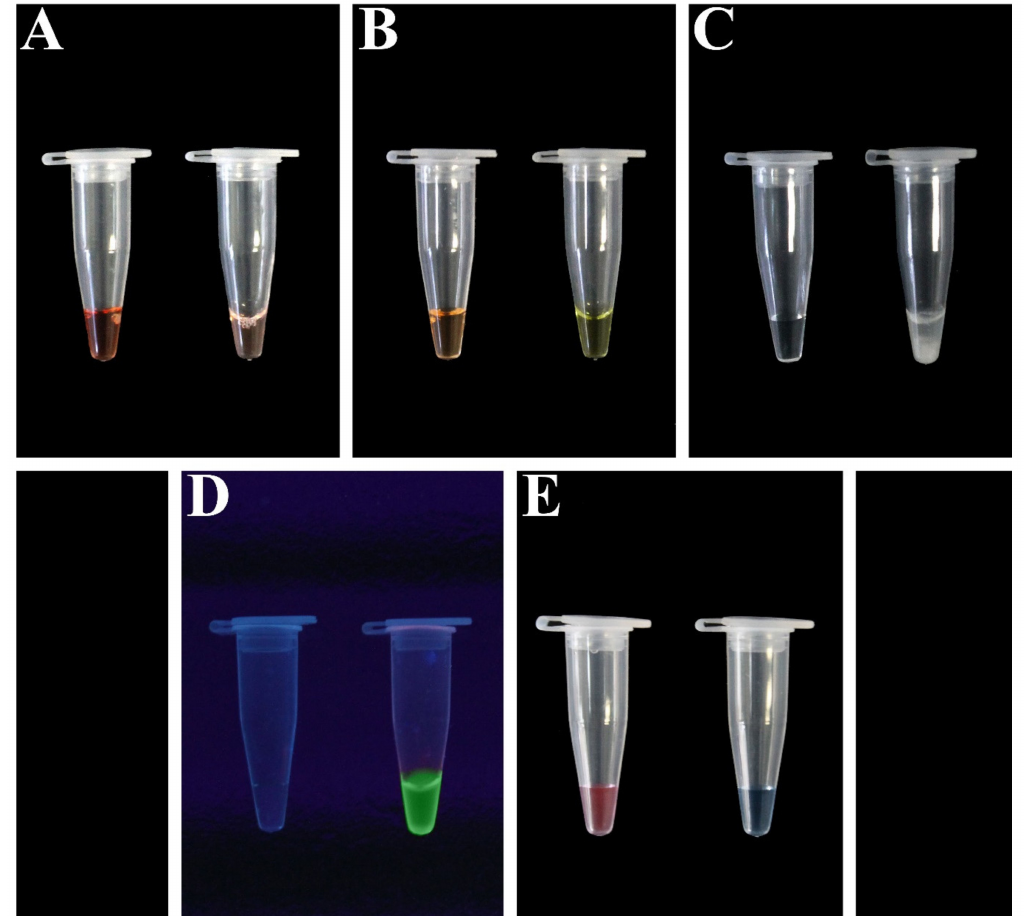
Figure 3. Di ff erent naked-eye results inspection. ( A ) Naked-eye observation under natural light of the reaction tube after addition of ethidium bromide in the reaction mixture for positive result discrimination. In the case of a negative result, a wine coloration is shown (left), while in a positive sample, the reaction mixture shows a salmon pink coloration (right). ( B ) Naked-eye observation under natural light of the reaction tube with Picogreen fluorescent dye in LAMP assay amplification. In the case of a negative result, the original orange color is retained (left), whereas in the case of a positive amplification, the original color of the dye changes permanently to yellow (right). ( C ) Result discrimination by ion indicator: (left) negative control that did not contain template DNA, showing clear mixture; (right) increases in turbidity observed on positive sample. ( D ) Detection of target DNA in LAMP reaction under UV light, using calcein as fluorescent metal indicator. (Left) negative control; (right) emitted fluorescence by positive sample owing to the interaction of calcein with residual magnesium ion. ( E ) Result discrimination by HNB (hydroxy naphthol blue): the color change of the mixture is from violet on the negative reaction (left) to sky blue on the positive reaction (right). SYBR Green I or Picogreen dye (the final dilution of 1:1.000) change the mixture color from the original orange to permanent yellow in the case of positive amplification (Figure 3B). The results